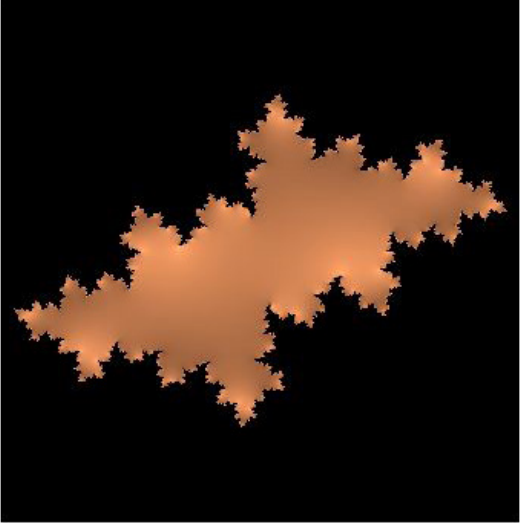
Figure 9. Douady rabbit